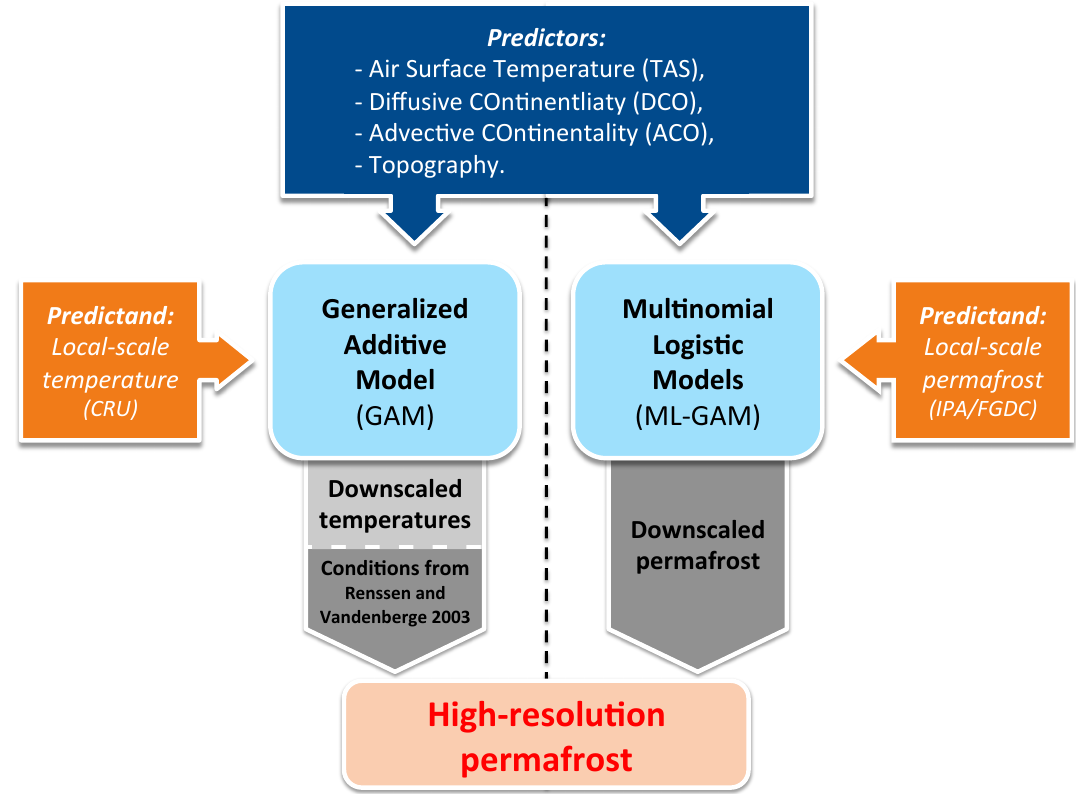
Fig. 2. Schema of the two downscaling